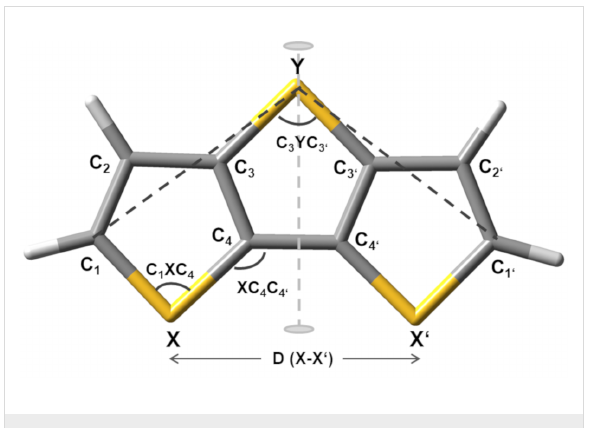
Figure 4: DFT quantum chemical calculated geometry of DTT 1 and general atom labelling for all heterotriacenes 1 – 4